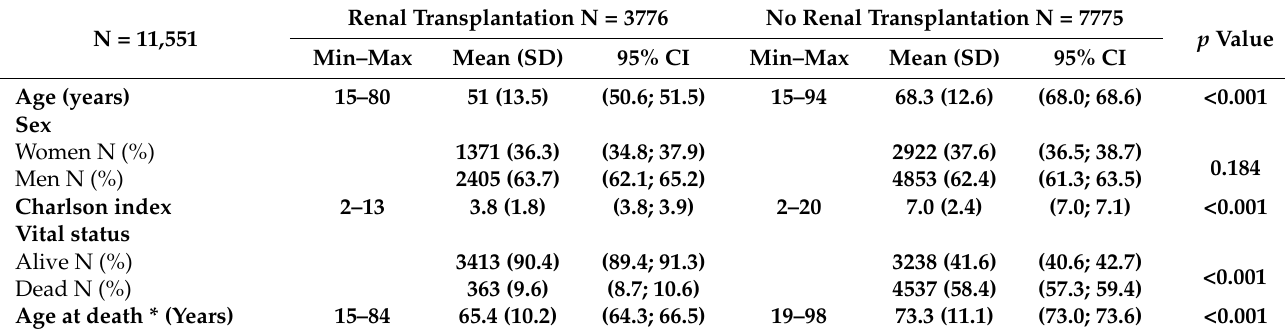
Table 1. Demographic characteristics of patients